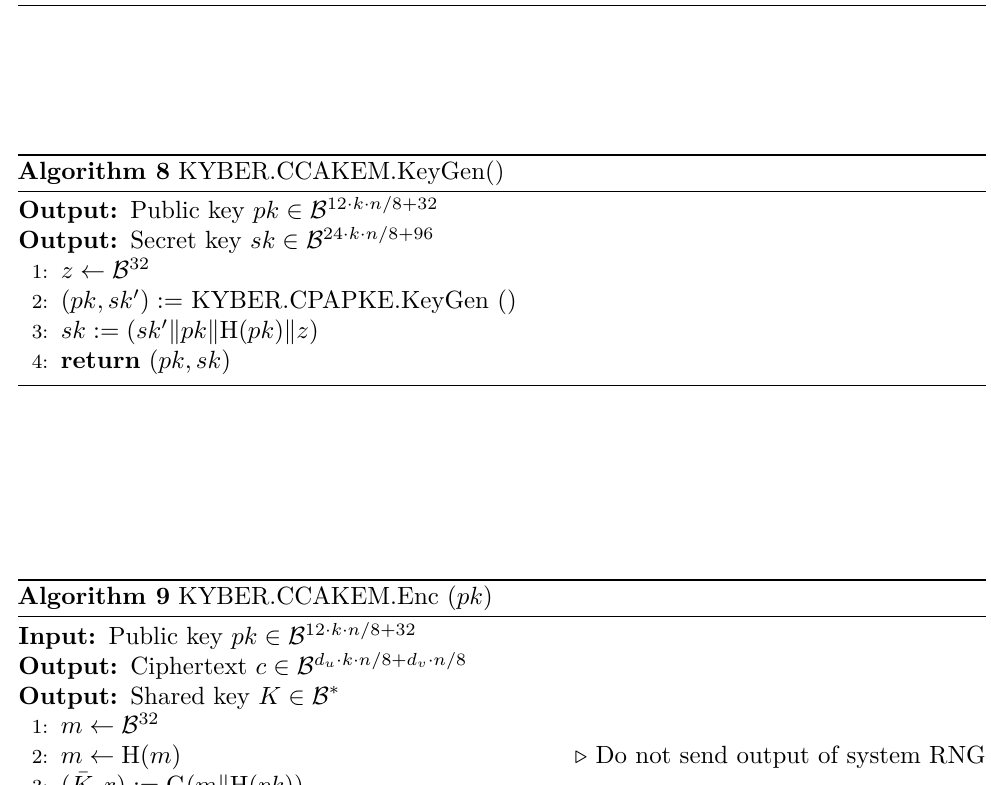
356 A Compact Hardware Implementation of CCA-Secure Key Exchange Mechanism CRYSTALS-KYBER on FPGA